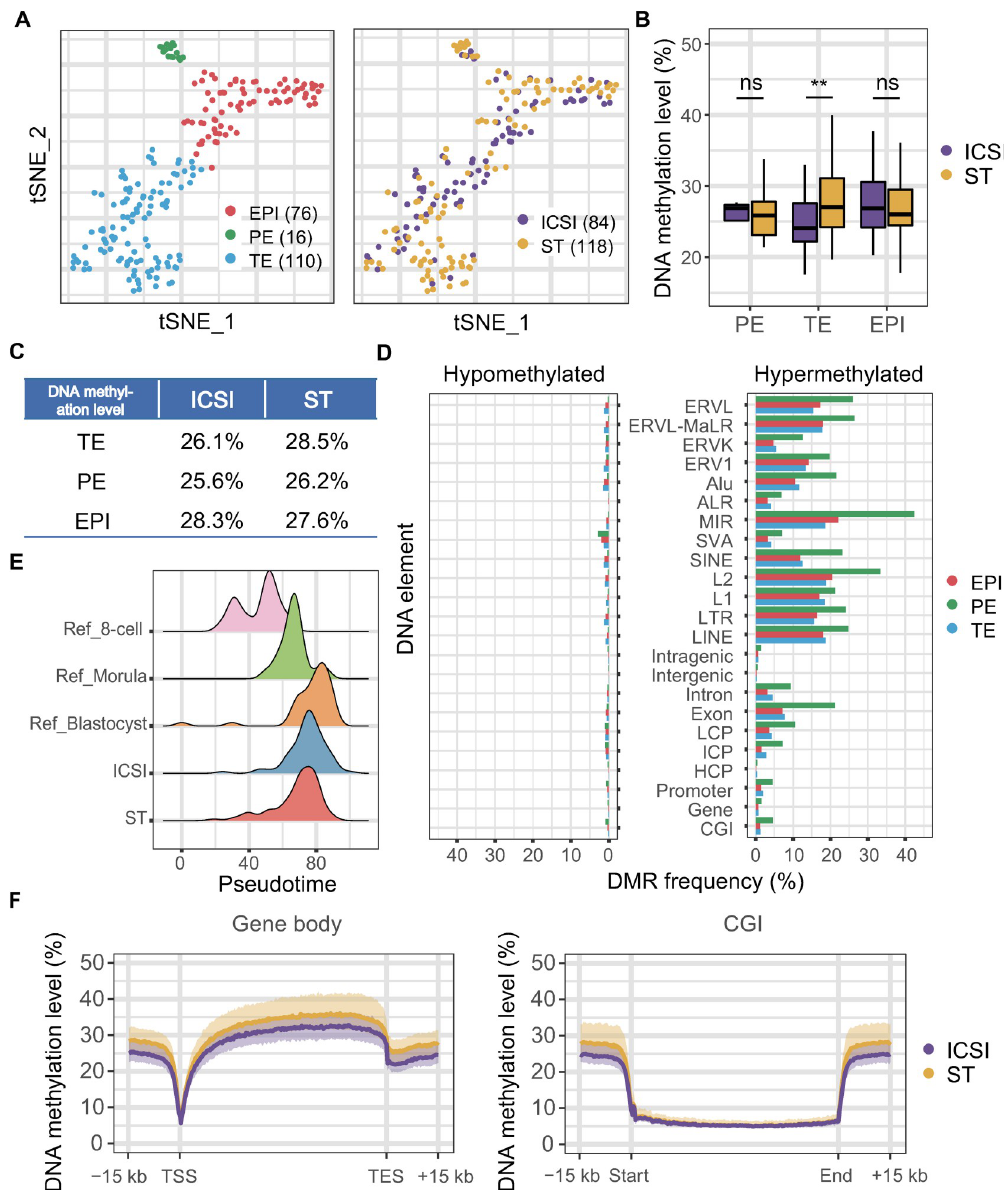
Fig 4. DNA methylome analysis of selected cells. (A) Two hundred and two cells remained after quality control and were projected onto a t-SNE map of their transcriptome data. The 3 lineages were clearly separated, while the ST and control groups clustered together well. (B, C) Overall DNA methylation levels for each lineage of cells. The p -values in the boxplot (B) were calculated by the Wilcoxon sum test (ns, p > 0.05; �� , p < 0.01). The DNA methylation levels of the embryonic cells distinguished by group (column) and lineage (row) are listed in Table (C). (D) DMR analysis. Hypomethylated regions (genomic regions with DNA methylation levels low in ST cells but high in ICSI cells) and hypermethylated regions (regions with DNA methylation levels low in ICSI cells but high in ST cells) were annotated to DNA elements. The DMR frequency shows the enrichment of DMRs within DNA elements. For example, a hypermethylated DMR frequency in CGIs indicates the ratio of the number of hypermethylated DMRs located in CGIs to the total number of CGIs. (E) Ridge plot of the DNA methylation pseudotime trajectory. Cells of an earlier stage (8-cell stage, morula, blastocyst; Ref, reference) were mixed with cells in this research, and PCA was performed. The value of PC1 was interpreted as pseudotime for each cell. (F) DNA methylation levels of gene bodies and CGIs and their flanking 15-kb regions. The methylation level of each cell in the corresponding group is indicated by the transparent area around the line. The solid lines indicate the mean methylation levels of ST (purple) and ICSI (yellow) groups. The numerical data are listed in S2 Data. CGI, CpG island; DMR, differentially methylated region; EPI, epiblast; ICSI, intracytoplasmic sperm injection; PE, primitive endoderm; ST, spindle transfer; TE, trophectoderm; t-SNE, t-distributed stochastic neighbor embedding.